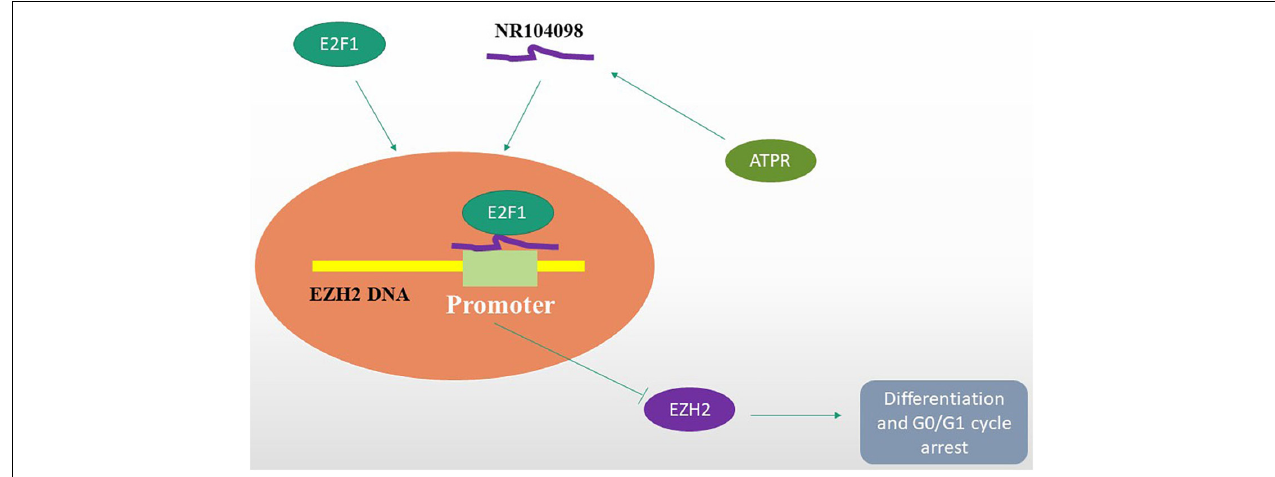
FIGURE 10 | A hypothetical working model of the role of lncRNA NR-104098 in AML proliferation and differentiation. Overexpression of lncRNA NR-104098 effectively increases the binding of E2F1 to EZH2 mRNA promoter, resulting in repression of EZH2 transcription that inhibits AML cell proliferation and induces differentiation. Meanwhile, an ATRA derivative ATPR could inhibit AML cell proliferation and induce differentiation though regulating the expression of lncRNA NR-104098. The arrows refers to the role of promotion, and the symbol of “T” refers to the role of inhibition.